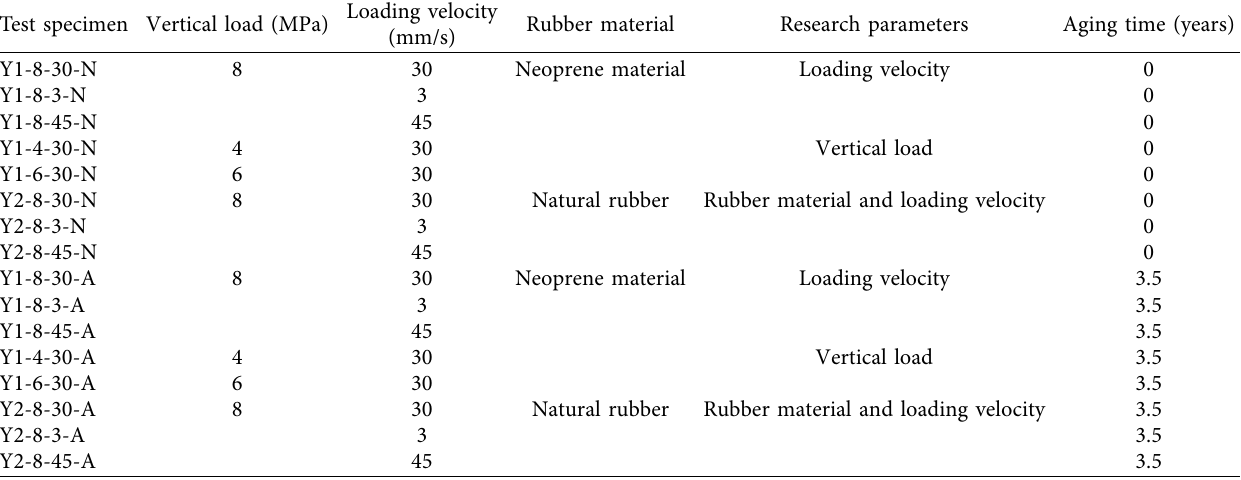
Table 1: Testing